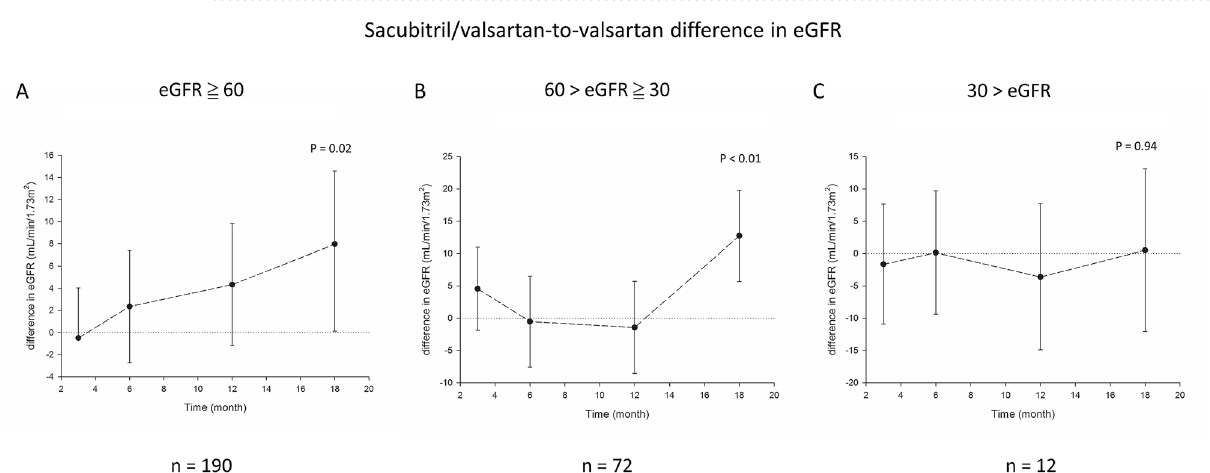
Figure 3. Difference of eGFR between patients on sacubitril/valsartan and valsartan stratified by baseline eGFR. ( A ) eGFR ≥ 60 ( B ) 60 > eGFR ≥ 30. ( C ) 30 > eGFR. eGFR, estimated glomerular filtration rate. P value calculated by generalized estimating